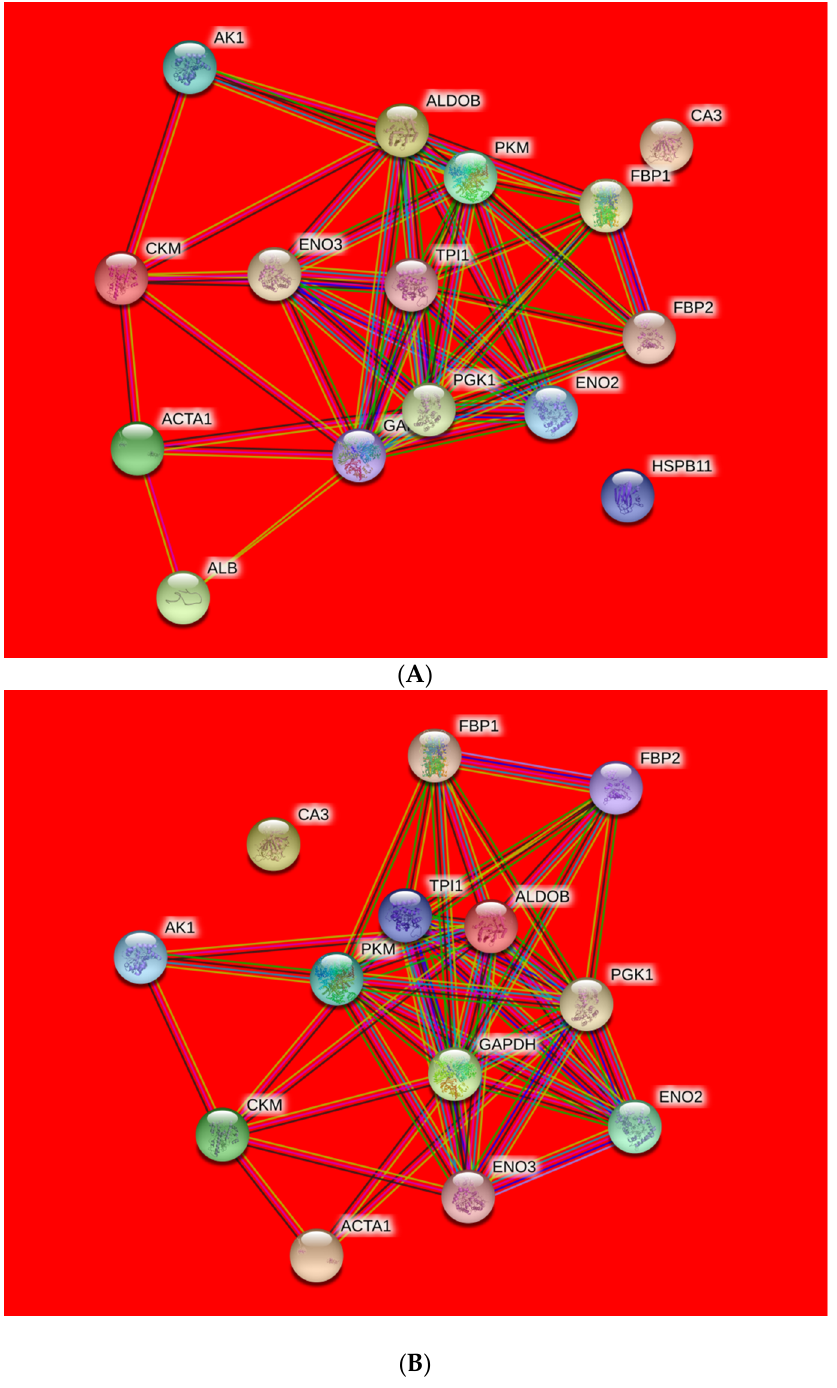
Figure 3. Protein–protein interaction (PPI) network of differentially expressed proteins from ovine M. longissimus lumborum ( A ) and M. psoas major ( B ) muscles.